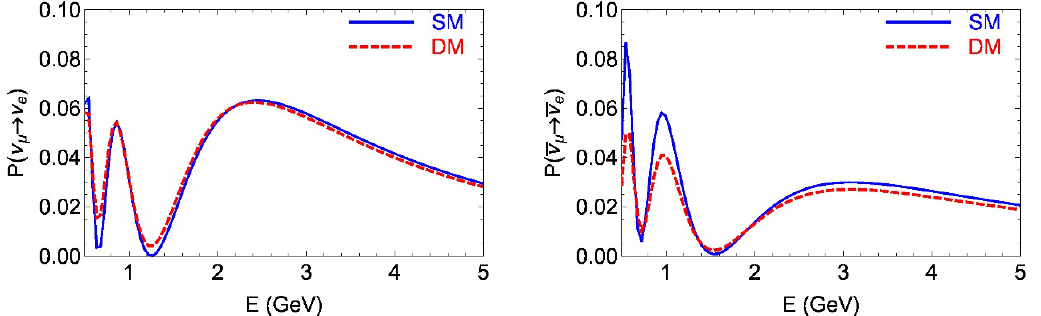
Figure 2 . The appearance probabilities at DUNE. The oscillation parameters in the DM scenario are: (cid:18) 0 = 35 : 3 (cid:14) , m 1 = 0 : 1 eV, (cid:15) = 0 : 0024 (cid:2) e i 0 : 7502 eV and (cid:15) 0 = 0 : 00041 (cid:2) e i 1 : 278 eV. See the text 12 for the other parameter